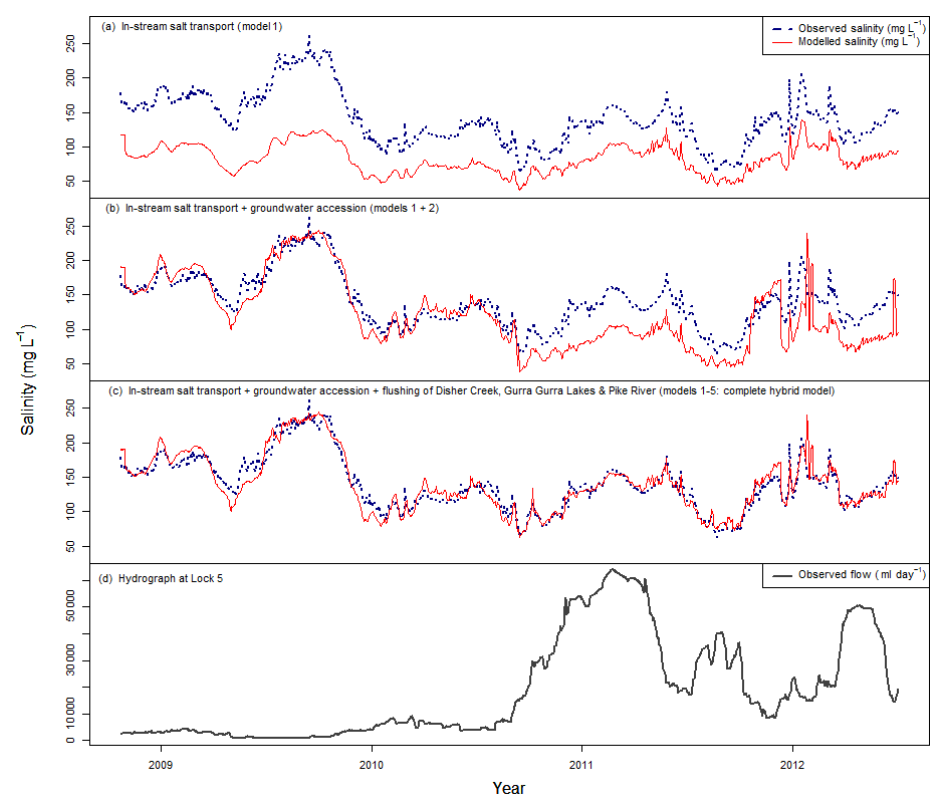
Figure 9. Measured versus modelled salinity at Lock 4 for the hybrid model and its components for the validation data, as well as corre- sponding hydrograph for Lock